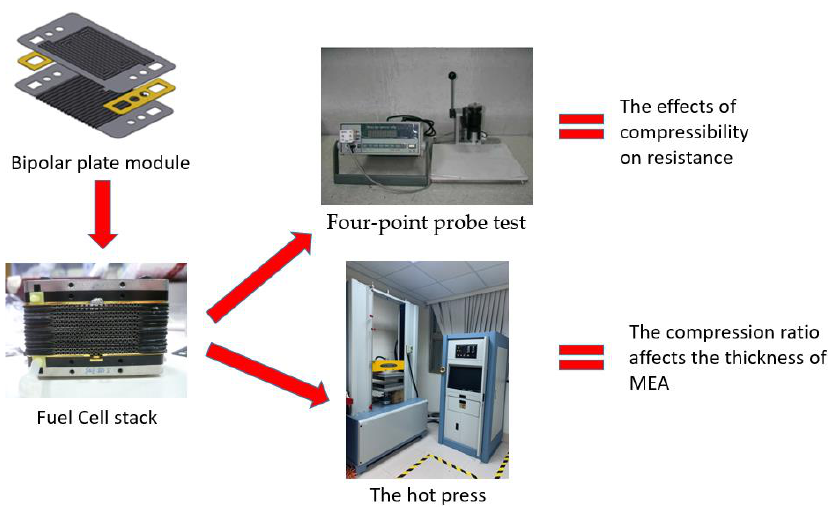
Figure 4. Experimental schematic flow.